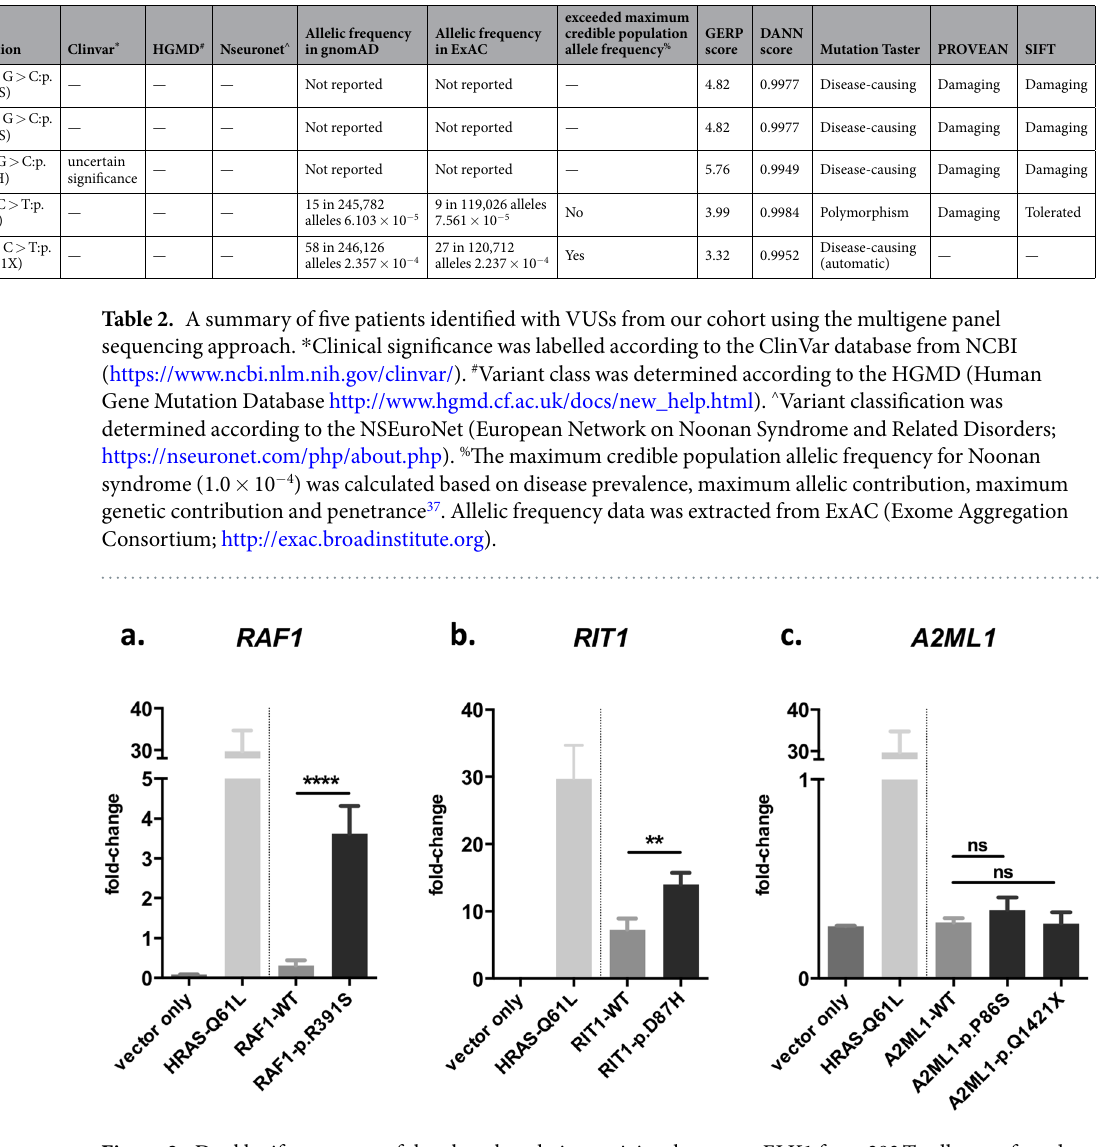
Figure 2. Dual luciferase assay of the phosphorylation activity changes to ELK1 from 293 T cells transfected with the corresponding expression and reporter plasmids. Statistical significance was derived using an unpaired t-test comparing the mutants with the corresponding WT. ** p < 0.01; *** p < 0.001; **** p < 0.0001; ns: not significant. Mutated human transcript with VUSs from ( a ) RAF1 ( b ) RIT1 and ( c ) A2ML1 from this study were compared with the wild-type transcript. The data are the mean ± SD from 3 determinations.